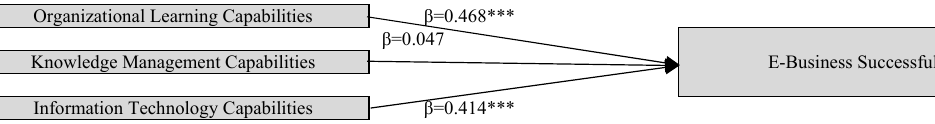
Fig. 4. Hypotheses of the